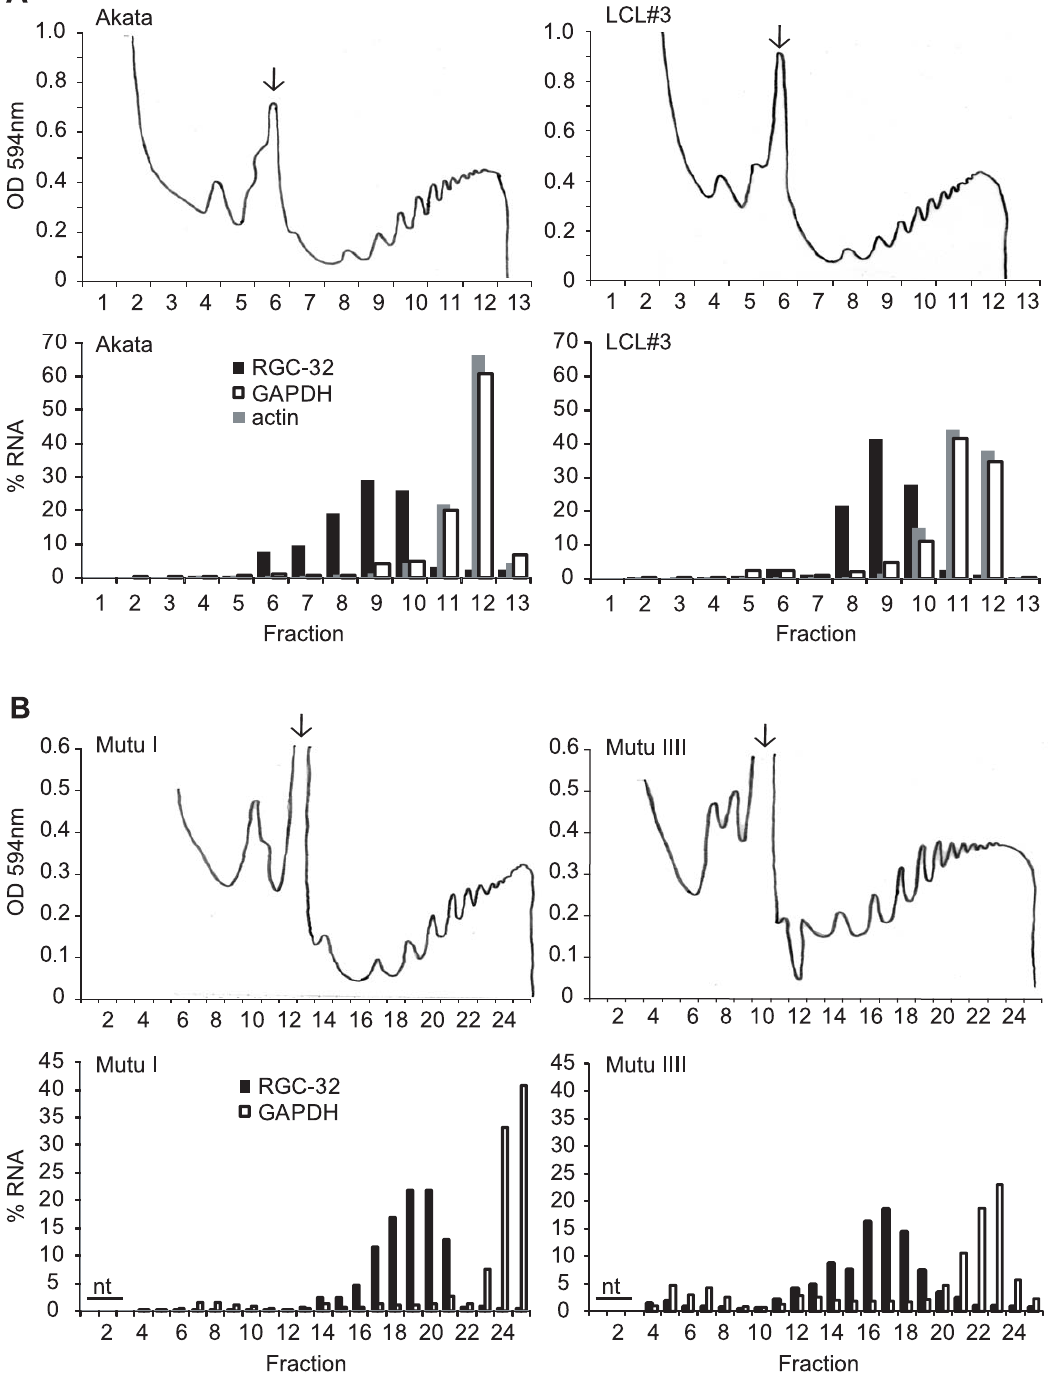
Figure 7. RGC-32 mRNA is associated with polysomes in latency I and latency III cells. Cytoplasmic extracts were sedimented on sucrose density gradients and 0.5 ml or 1 ml fractions collected with continuous monitoring of absorbance at 254 nm (upper panels in A and B). 80S monosome peaks are indicated by arrows. Transcript levels in each fraction were determined using Q-PCR and specific primers to RGC-32 (black bars), GAPDH (open bars) and actin (grey bars). Transcript levels are expressed as a percentage of the total transcript levels detected across the gradient (nt indicates fractions that were not tested). (A) Parallel analysis of Akata (latency I, no RGC-32 protein expression) and LCL # 3 (latency III, RGC-32 protein expressed) polysomes. (B) Parallel analysis of Mutu I (latency I, no RGC-32 protein expression) and Mutu III (latency III, RGC-32 protein expressed) polysomes.